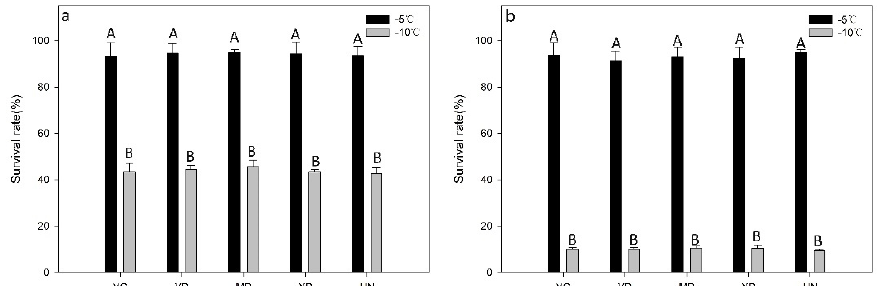
Figure 1. Survival rates of different isolates under low temperatures for 8 h ( a ) and 24 h ( b ). The isolate abbreviations are its place of origin used as IDs. YD and YC isolates are from the subtropical zone; MP is from the warm temperate zone; XB and HN are from the mid-temperate zone. Standard errors are represented by error bars, different capital letters (A, B) above bars denote significant differences at p < 0.01.